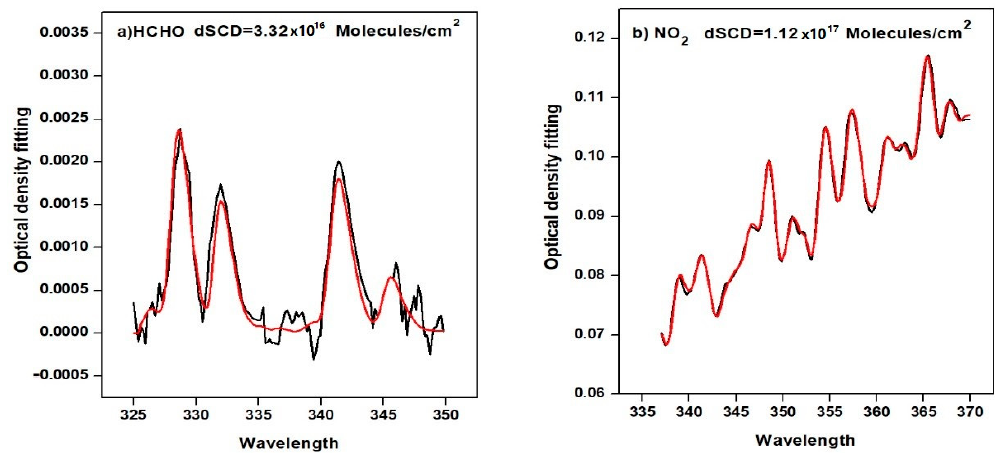
Figure 2. Typical DOAS fit for formaldehyde (HCHO) and nitrogen dioxide (NO 2 ) at 30 ◦ elevation angle on 01 January 2020 over Shanghai. Fitted optical densities are represented by the red line, while measured densities are denoted by the black line.